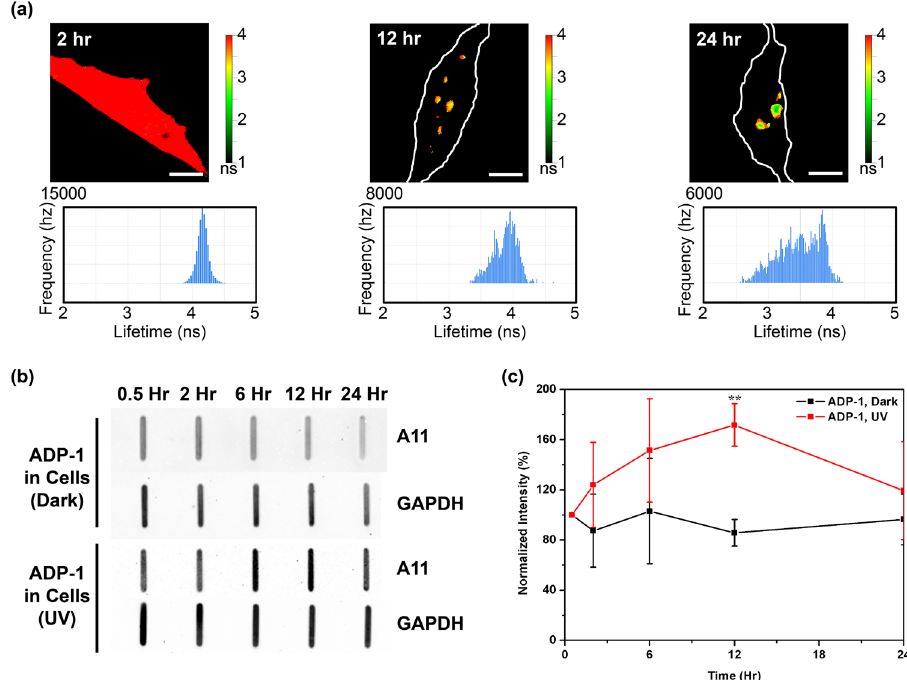
Fig. 2 GA DPRs delivered by ADP-1 and 2 probes oligomerized in cells. a Time-course fl uorescence lifetime images and histograms of ADP-2 in SH-SY5Y cells. 1 μ M ADP-2 were treated to cells and photoinitiated by UV light (wavelength: 335 – 379 nm, power density: ≤ 8.24 mW/cm 2 , duration: 1 min). Cell periphery was contoured with a white line in 12th and 24th hours, respectively. Images were taken at 2nd, 12th, 24th hour after UV illumination; scale bars indicate 5 µ m. b A11 immunoblotting with cell lysates from SH-SY5Y cells received ADP-1 (1 µ M) treatment with or without photoinitiation. After photoinitiation, cell lysates at different time points were harvested and analyzed. c Quanti fi cation analysis of A11 immunoblot of SH-SY5Y total cell lysates. The signal of A11 staining was fi rst normalized to GAPDH staining and then compared to signal at 0.5 h incubation. Three biological replicates were carried out ( r = 3). Mean and standard deviation for ADP-1, UV = 171.7 ± 17.0; ADP-1, dark = 85.8 ± 10.6. ** indicates statistical signi fi cance where p value < 0.01 (analyzed by two-sided Welch ’ s T test, p value = 0.005, degree of freedom = 3, t value =